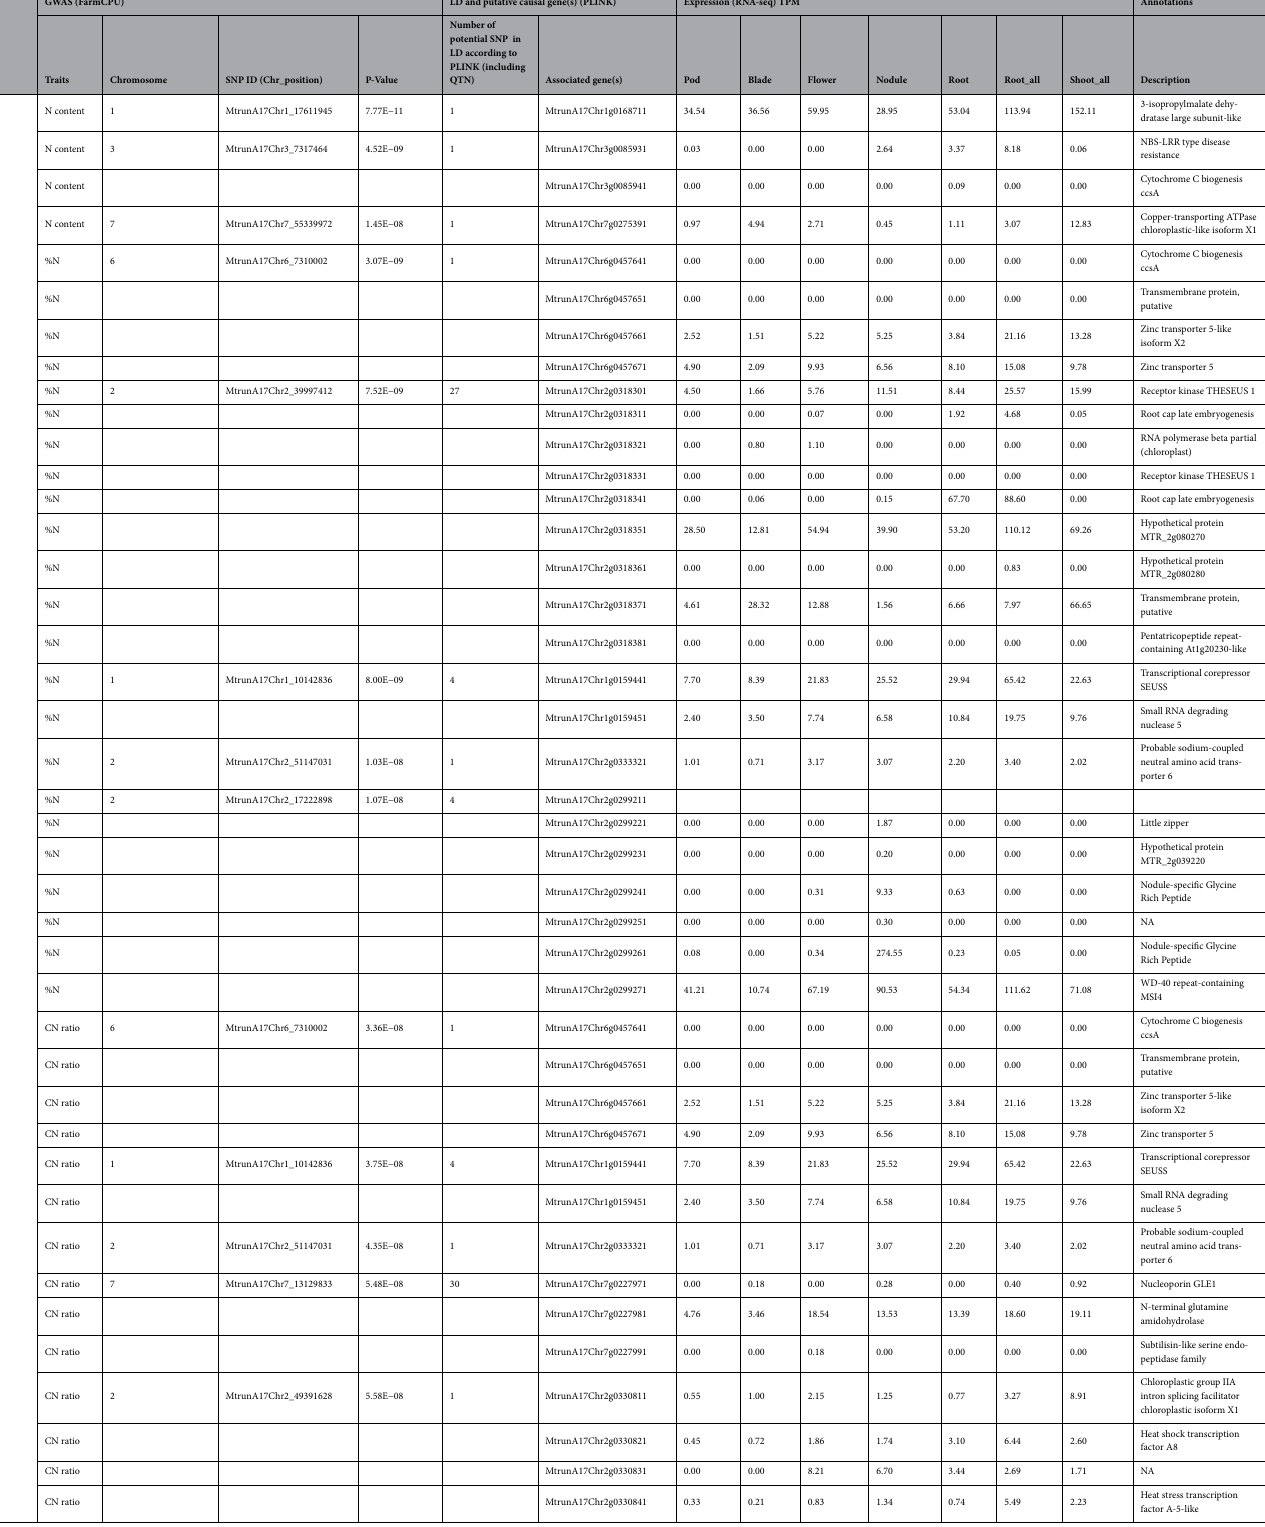
Table 1. Top five QTNs significantly associated with different seed size traits (i.e. weight, area, majellipse, minellipse) and seed compositions (S content, N content, %S, %N and C/N ratio). SNP/QTN names, positions and p-values are indicated from FarmCPU. Numbers of potential associated SNP(s) and putative causal genes are indicated from PLINK analysis. Gene expression in major Medicago plant organs, as well as tentative gene annotations are indicated. A more exhaustive list of highly significant QTNs related to all seed traits is provided as Supplementary Table S6, and complete lists of SNPs and their associated p-values are provided as Supplementary Tables S2 to